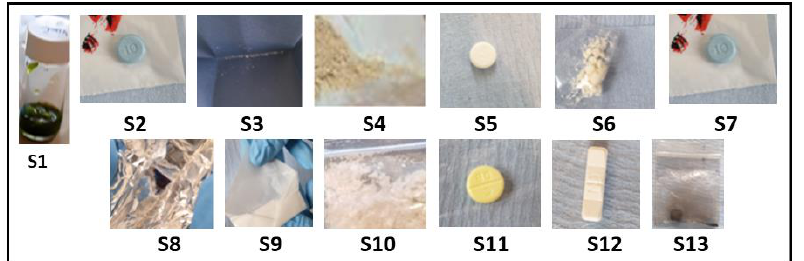
Figure 2. Images of each sample surrendered for analysis at the drug-checking clinic; each sample was weighed and described prior to test (Table 1). Please note sample S1, a herbal material, was suspended in methanol prior to the image being taken.